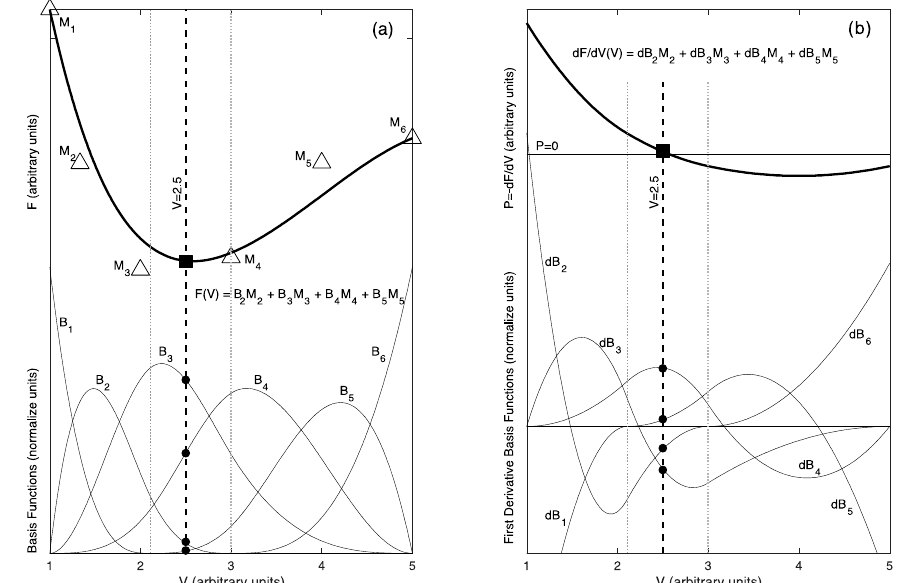
Figure A1. Equation of state example using a cubic b-spline representation on three intervals. Panel ( a ) (left side): Helmholtz energy (F) as a function of volume (V) is shown as a thick line. Panel ( b ) (right side): Pressure, as the negative of the first derivative of Helmholtz energy, is shown. Vertical dotted lines show the internal spline boundaries between three intervals of volume. B-spline basis functions are shown at the bottom of each panel with labels B i and dB i . The six model parameters (labeled M i ) required to represent the function are shown in panel (a), plotted at their control point locations. Note that the control point locations are implicit in the distribution of the intervals and are not separately tabulated in the model description. The evaluation of the function at a specified volume (vertical dashed line) is illustrated in each panel where the function is given as a sum of the product of basis function values and model parameters. The evaluation of the functions for any other value of volume is undertaken by the same linear analysis. The model parameters, in units of energy, can be determined through a fit of pressures and volumes based on the linear relationships as shown on the right side.